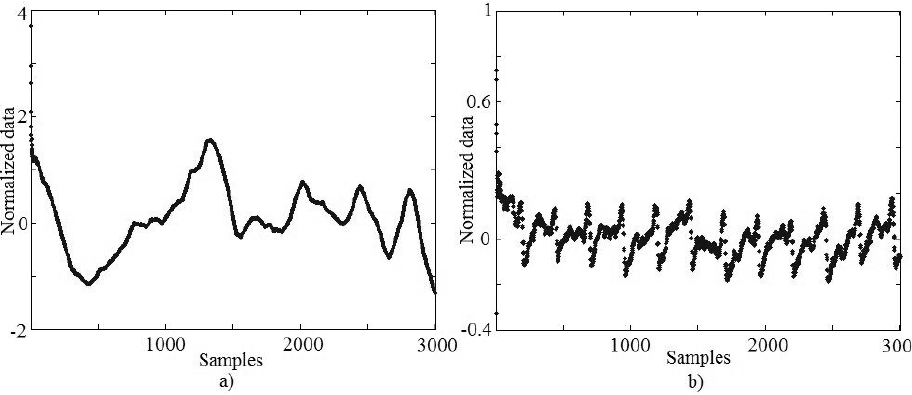
Figure 5. Normalized signals comparison. (a) Infrared signal. (b) Weld